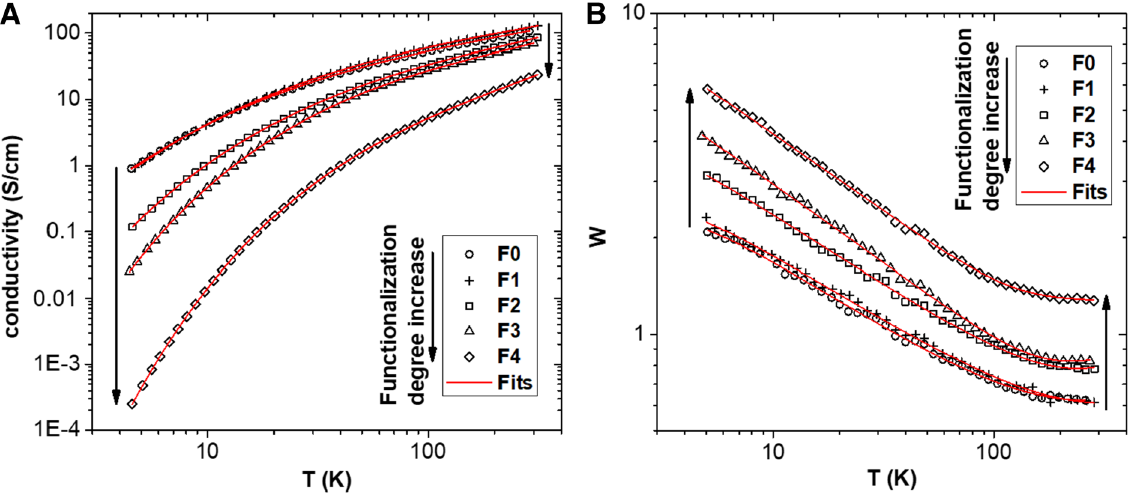
Fig. 3 Conductivity σ ( A ) and reduced activation energy W ( B ) as a function of temperature for different functionalization degrees. Continu- ous lines show the best